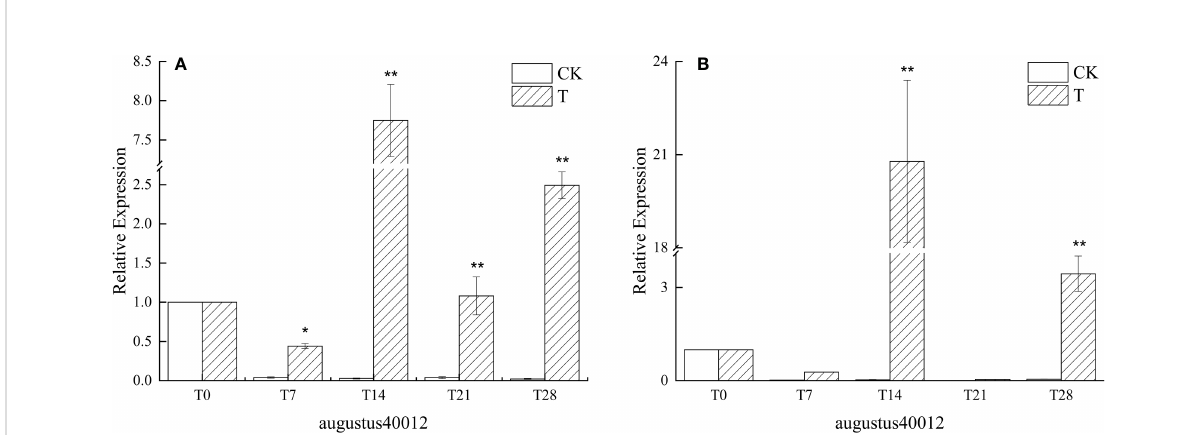
FIGURE 3 Relative expression of the similar gene augustus40012 of AP1 in the leaves of plants with different treatments in L. chinense var. rubrum. ‘ (A) ’ represents the relative expression of similar genes of AP1 in leaves of ‘ Xiangnong Xiangyun ’ under different treatments. ‘ (B) ’ represents the relative expression of similar genes of AP1 in leaves of ‘ Hei Zhenzhu ’ under different treatments. ‘ T ’ represents the low-temperature treatment group and ‘ CK ’ represents the blank control group treated at 25°C. '*' signi fi cant difference, '**' extremely signi fi cant